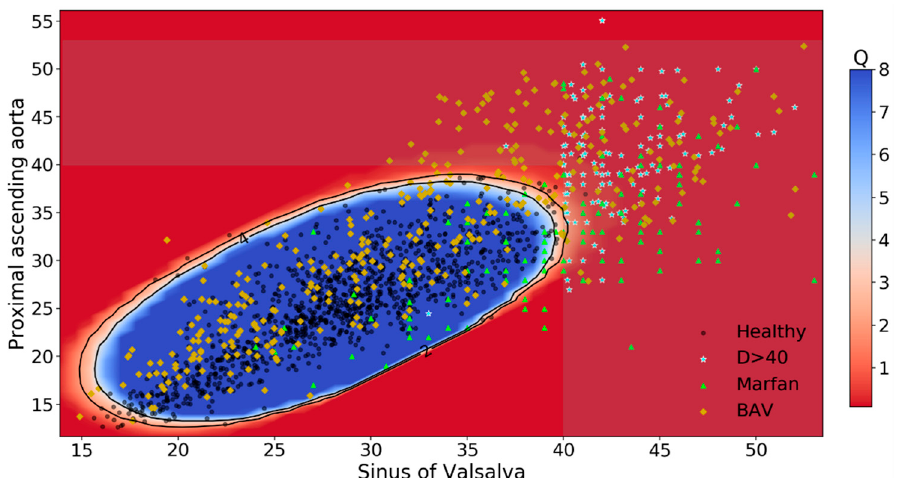
Figure 1. Heatmap of Q-score obtained by an OC-SVM model. As an illustrative example, this heatmap of Q-score predicting normalcy by using only proximal ascending aorta (PAA) and sinuses of Valsalva (SOV) diameters (blue dots) is reported. As a reference, the thoracic aorta dilatation region [defined as diameter (D)>40 mm for at least one aortic segment] has been slightly darkened, and patients represented as stars. Inside the blue region, Q-scores are > 4% indicating normalcy. The black solid contour lines correspond to the level sets Q-score = 2% and 4%. Orange triangles are patients with Marfan syndrome, green diamonds patients with bicuspid aortic valve (BAV).